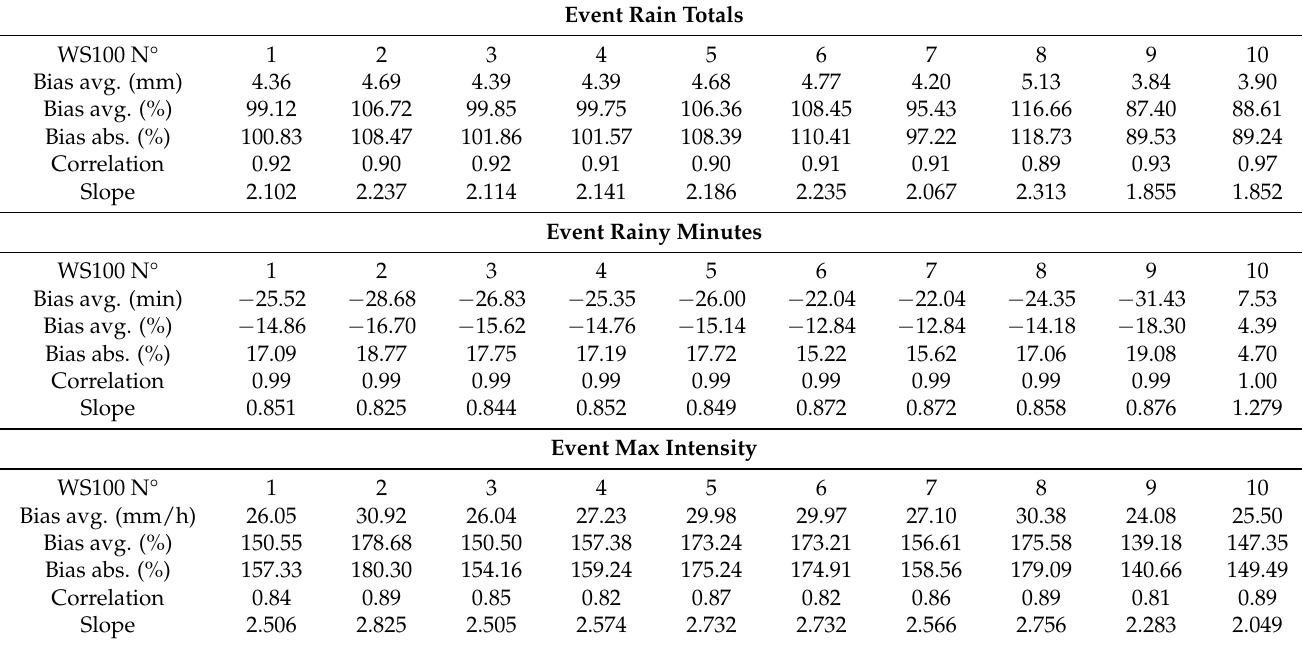
Table 5. Statistical results of the comparison of the WS100 sensors and Parsivel 2 . Event Rain